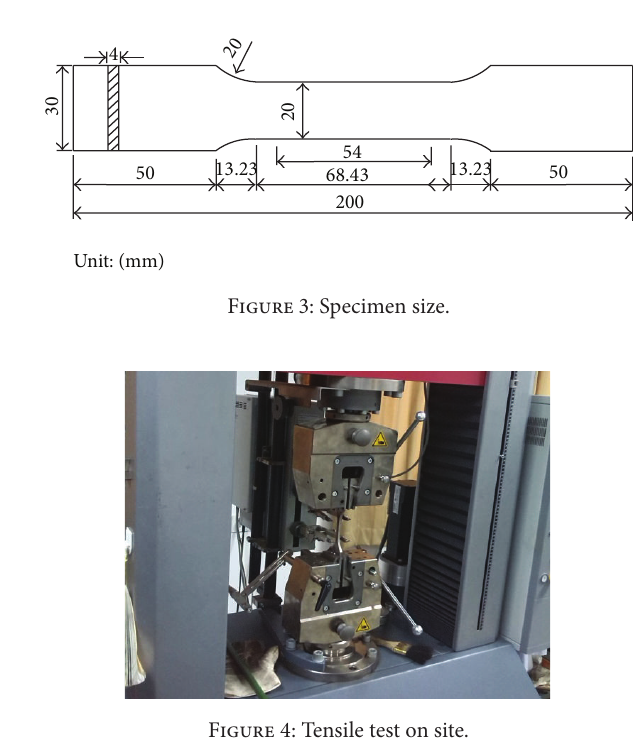
Figure 4: Tensile test on site.